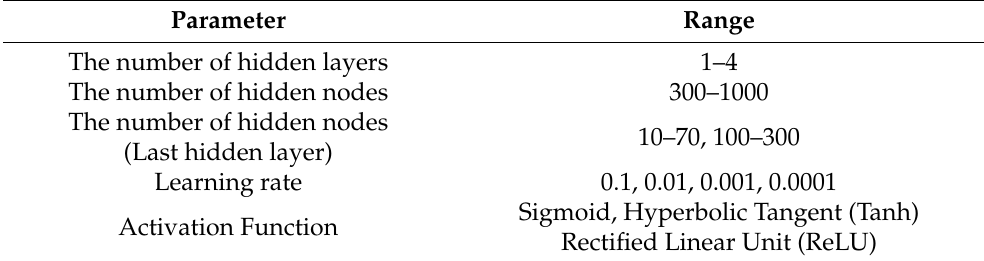
Table 1. The range of each parameter for the roll force and motor load prediction models.